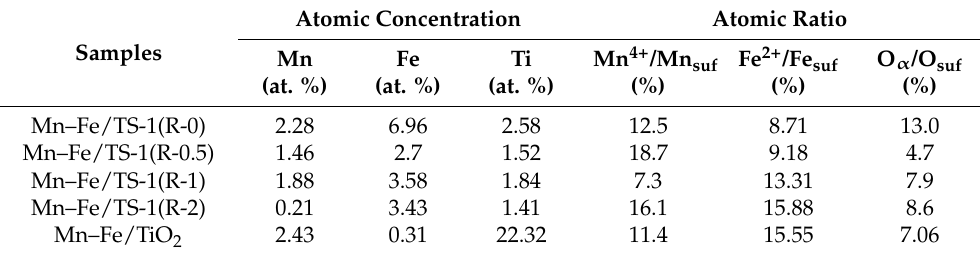
Figure 5. Mn 2p ( a ), Fe 2p ( b ), O 1s ( c ), and Ti 2p ( d ) XPS spectra. Table 2. The surface compositions of the obtained samples. Table 2. The surface compositions of the obtained